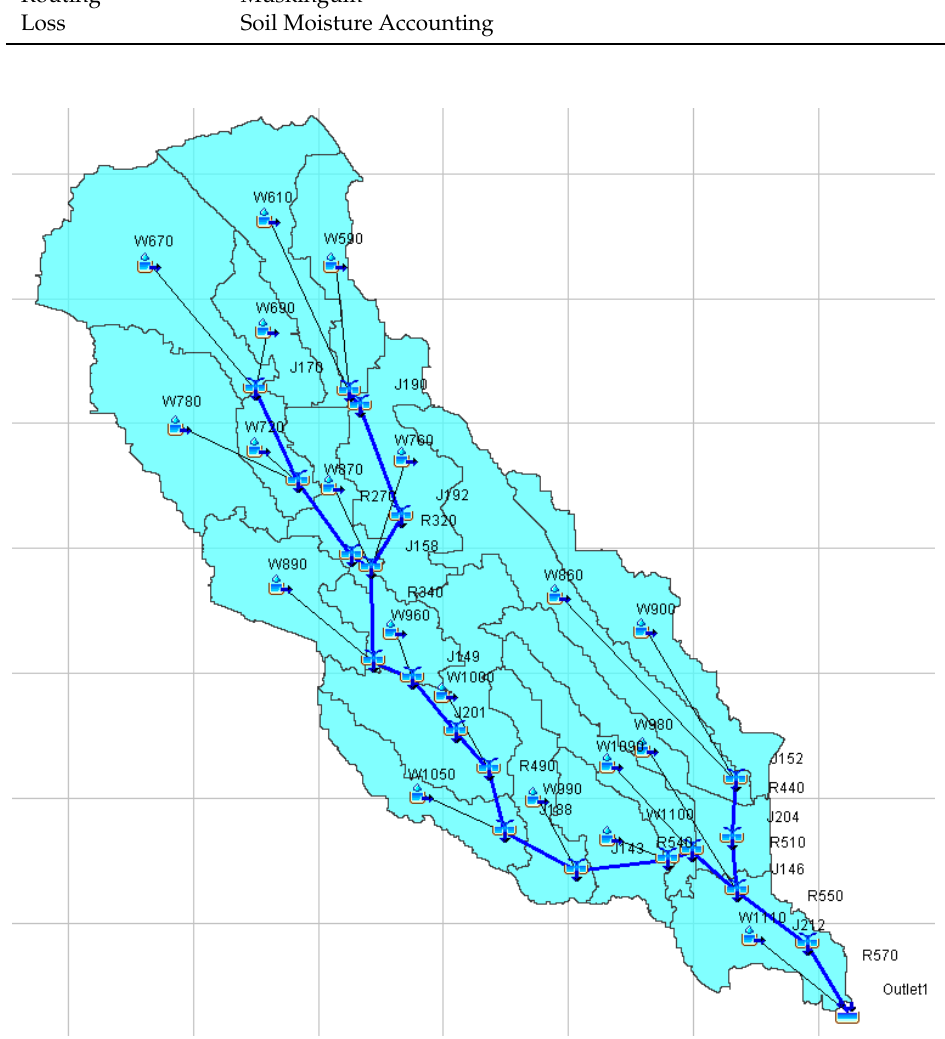
Figure 5. The schematic of the Sturgeon Creek Watershed created by HEC-HMS. The naming of sub-watersheds, reaches and junctions begins with W, R and J,